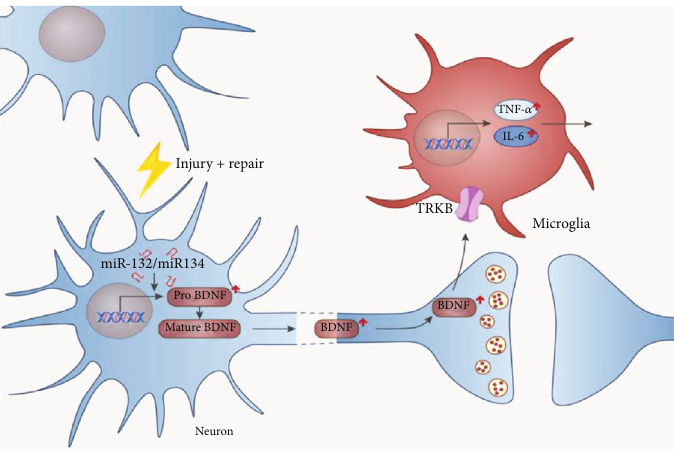
Figure 1: BDNF is reported to be involved in regulating cortical plasticity through activation of microglia, which secreted the proin fl ammatory factors such as TNF- α and IL-6. After injury and surgical repair of the peripheral nerve, microRNA (miR-132/134) is also reported to regulate the levels of BDNF.